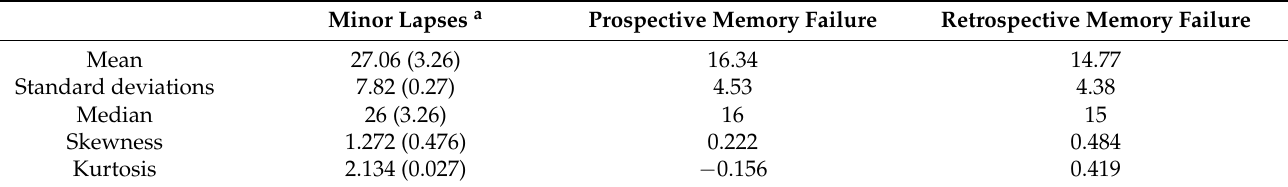
Table 2. Descriptive statistics for outcome measures (N =